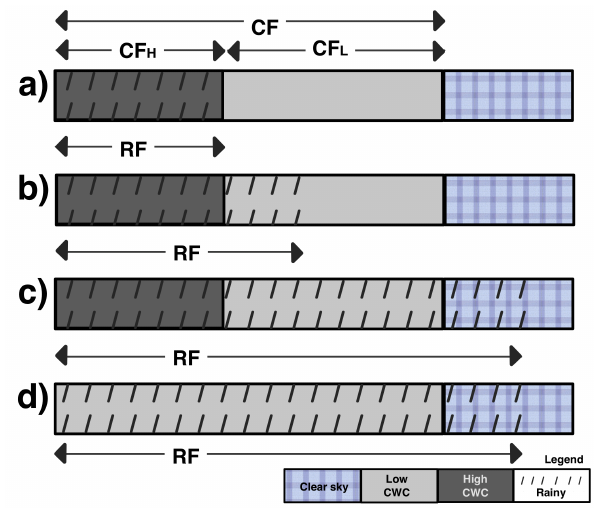
Fig. 4. Four horizontal views of a grid box, with the splitting of the Figure 4: Four horizontal views of a grid box, with the splitting of the CWC in two regions of low and CWC in two regions of low and high CWC. RF and CF are the rain high CWC. RF and CF are the rain and the cloud fractions, with CF L representing the cloud fraction and the cloud fractions, with CF L representing the cloud fraction in in the low CWC region and CF H the cloud fraction in the high CWC region (see text for details about the low CWC region and CF H the cloud fraction in the high CWC differences in accretion and rain evaporation in a, b, c and d). region (see text for details about differences in accretion and rain evaporation in a , b , c and d ).